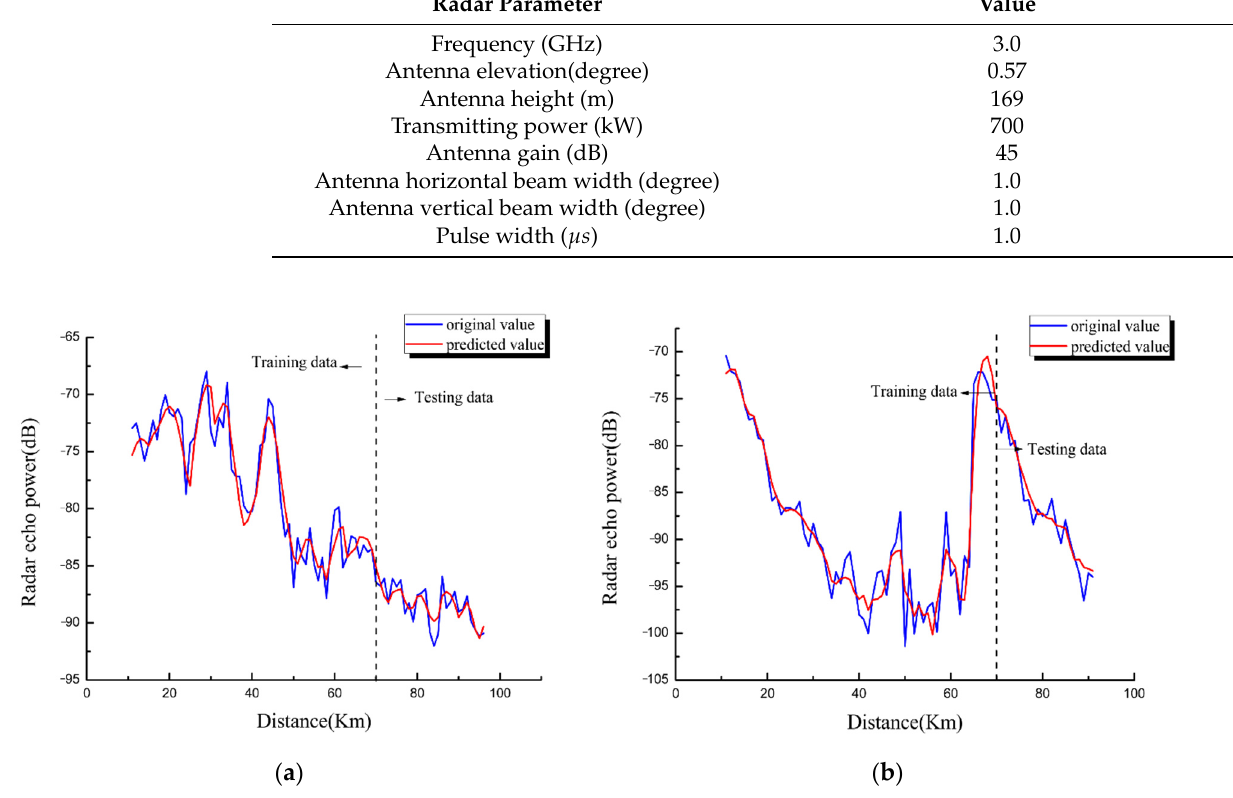
Figure 13. The radar echoes power predicted result of the proposed method: ( a ) 90° azimuth; ( b ) 120° azimuth. Table 13. Evaluation results of predictive capacity.